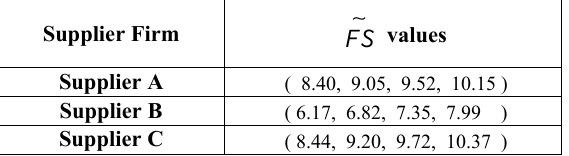
Table 4. Suppliers’ scores.